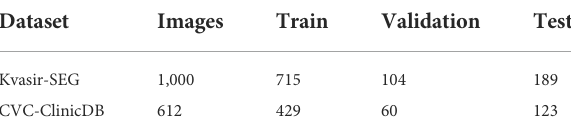
TABLE 2 The two publicly available colorectal polyp segmentations datasets used in experiments.